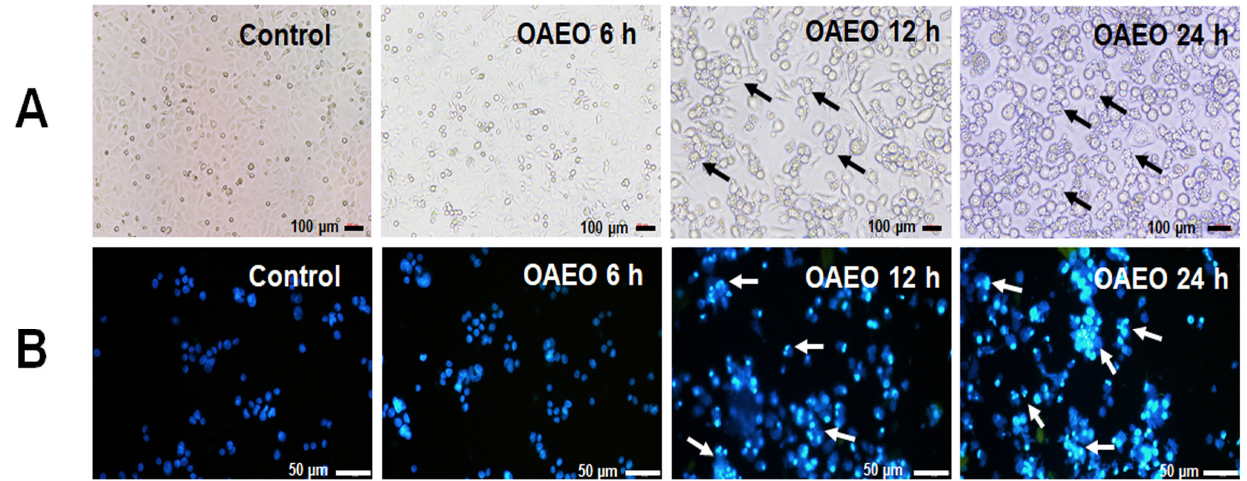
Figure 4. ( A ) Morphology of vehicle control and OAEO-treated AGS cells at 6, 12, and 24 h, as observed by inverted microscope. ( B ) Nuclear morphology of vehicle control and OAEO-treated AGS cells at 6, 12, and 24 h, as visualized by DAPI staining. All determinations were performed in triplicate as independent experiments.